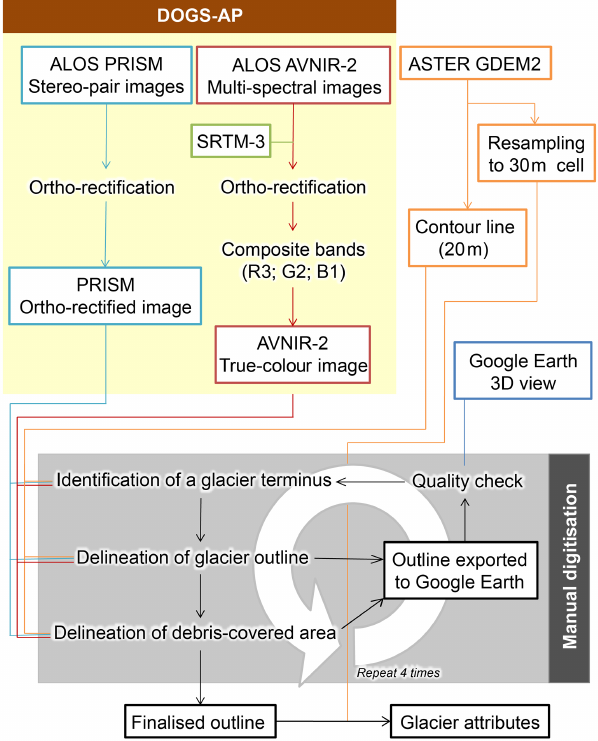
Figure 2. Flow chart of data processing and manual delineation for the ALOS-derived glacier inventory. Control and tracing of delin- eation quality were conducted four times prior to finalising glacier